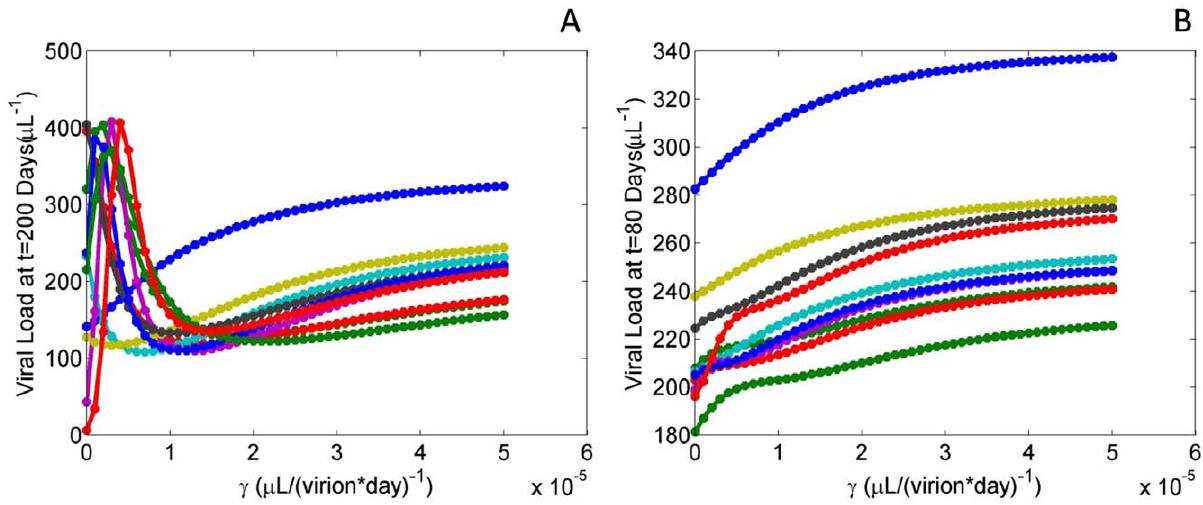
Figure 4. Sensitivity analysis of the c parameter. Graphs depicting 10 representative parameter sets, plotting viral load at various time points over varied values for c . Each distinct curve represents simulations obtained from a single, randomly determined, physiological parameter set. (A) Plots for viral load measured at t=80 days. For the majority of curves, viral load spikes at smaller values of c and then decreases to a steady state for higher c values. Several simulations reveal viral loads quite close to and at 0 virions/( m L) 2 1 for c ~ 0 . (B) Plots for viral load measured at t=200 days. Most curves are seen to monotonically increase over increasing values of c , suggesting a direct relationship between high adaptive Treg production and high steady state viral loads.